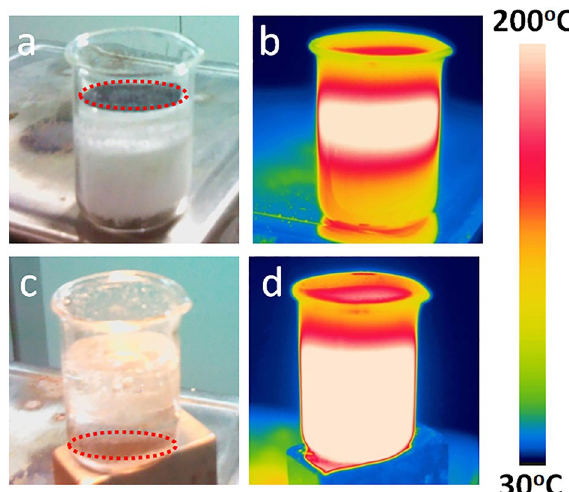
Figure 3. Photographs and IR images of charged molten salts under ( a , b ) fixed and ( c , d ) movable charging mode. The red circle highlights the position of the